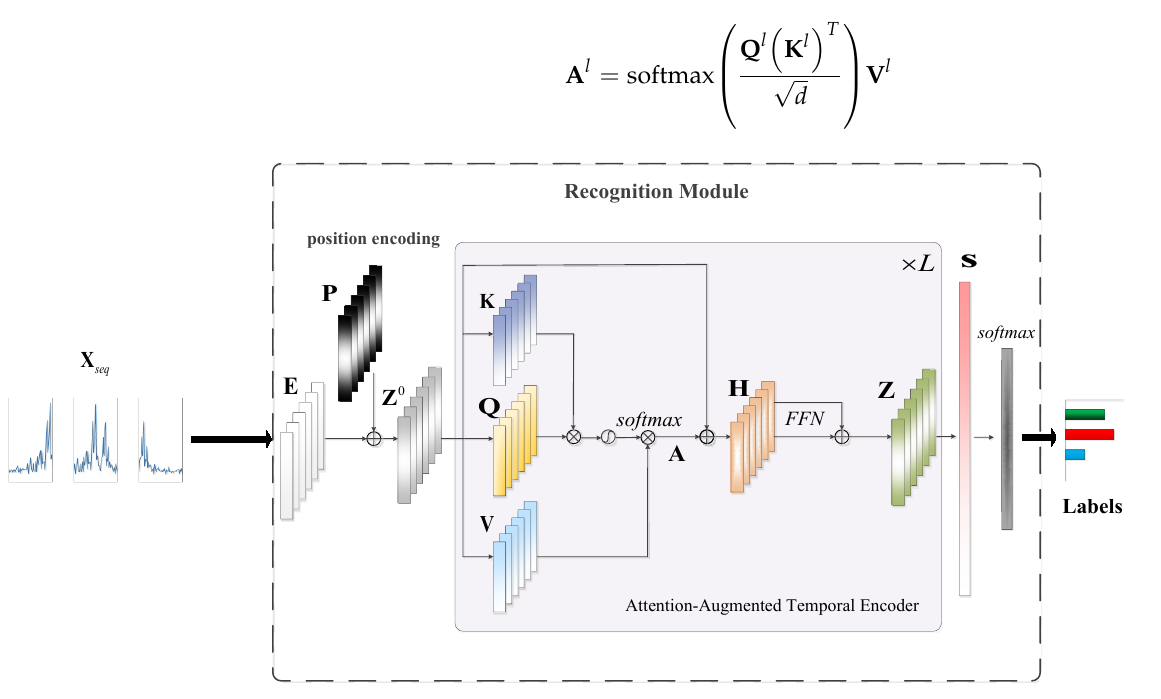
Figure 5. Detailed structure of the recognition module.